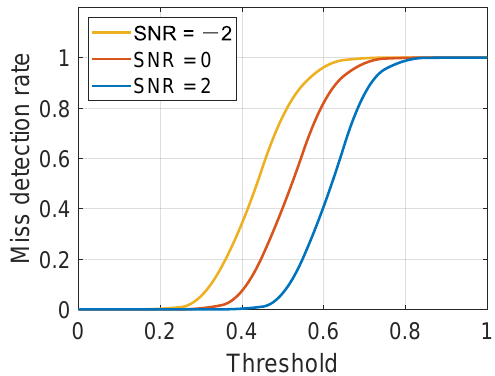
Figure 14. Misdetection rate for different